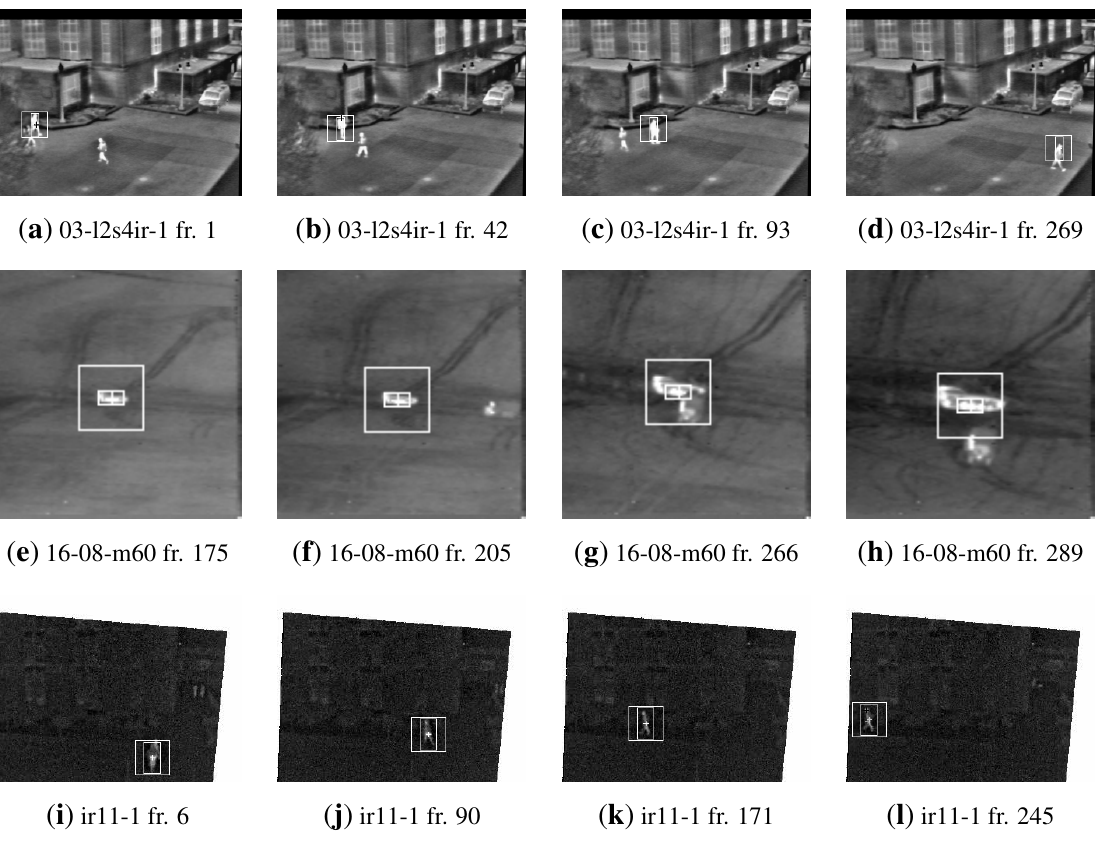
Figure 3. Tracking results by running the proposed algorithm on sample sequences extracted from each considered dataset. sequence 16-08-m60; ( i – l ) AIC ir11-1.